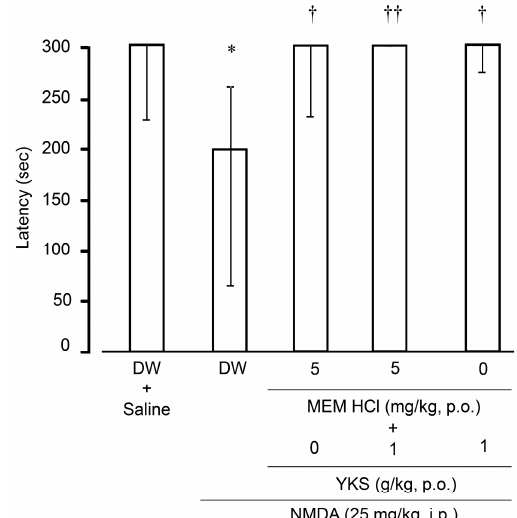
Figure 4. Effects of MEM, YKS, and their combination on NMDA-induced learning and memory disturbances in a step-through passive avoidance task. MEM hydrochloride (5 mg/kg), YKS (1 g/kg), their combination, or distilled water (DW; 10 ml/kg used as a control) was orally administered to mice once a day for 14 days. An acquisition trial was then performed 1 h after the final administration. NMDA (25 mg/kg) or saline (10 mL/kg as control) was injected intraperitoneally 30 min before the trial. After 24 h, a retention trial was performed. The cut-off time of the latency was set at 300 s. Data represent median ± interquartile range ( n = 9). * p < 0.05 versus vehicle control: